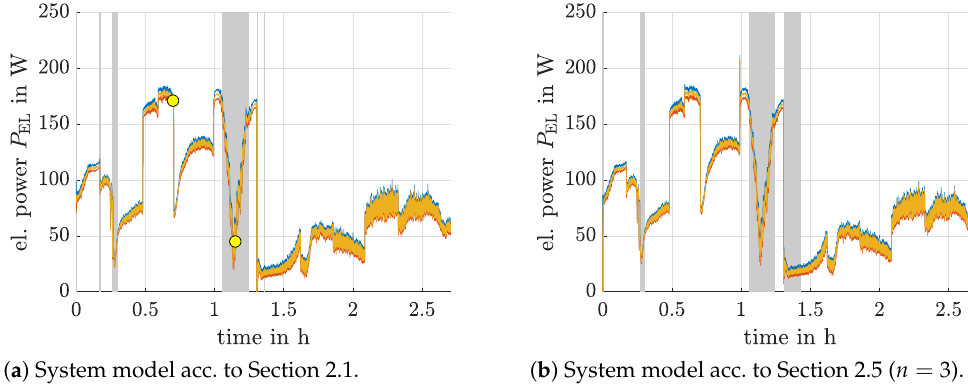
Figure 11. Detection of operating points exceeding the maximum power